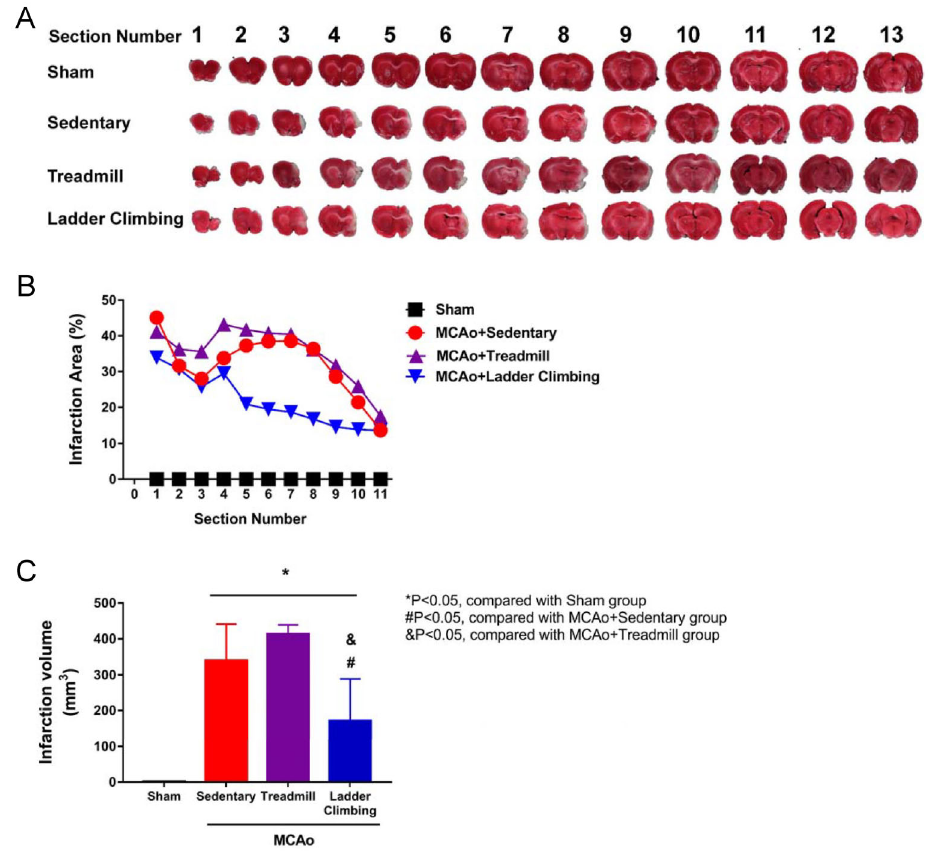
Figure 10. TTC staining to assess the cerebral infarction volume after stroke rehabilitation in sham rats and rats with middle cerebral artery occlusion (MCAo) submitted to different exercise protocols. A , Brain section images. B , Staining ratio of each brain section. C , Cerebral infarction volume on day 28. Data are reported as means ± SD (ANOVA and t